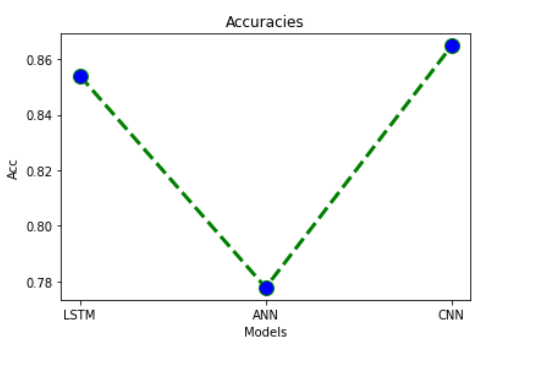
Prediction using Convolutional Neural Networks